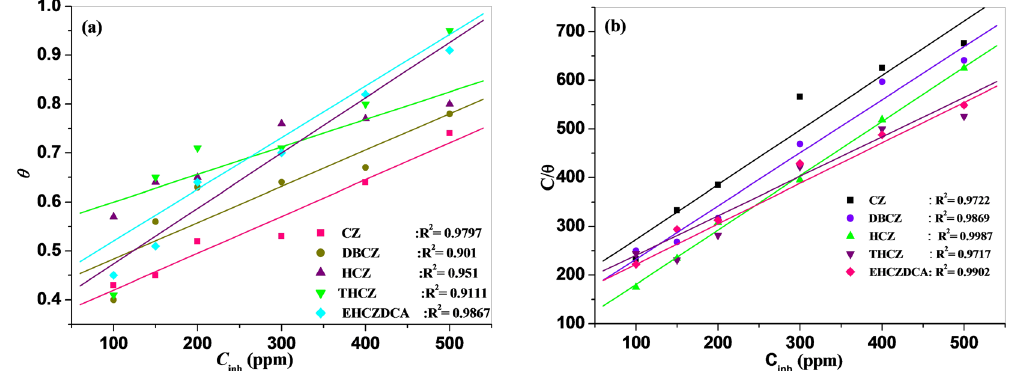
Figure 5. Adsorption isotherm plots of ( a ) Freundlich, ( b ) Langmuir for mild steel in the presence of